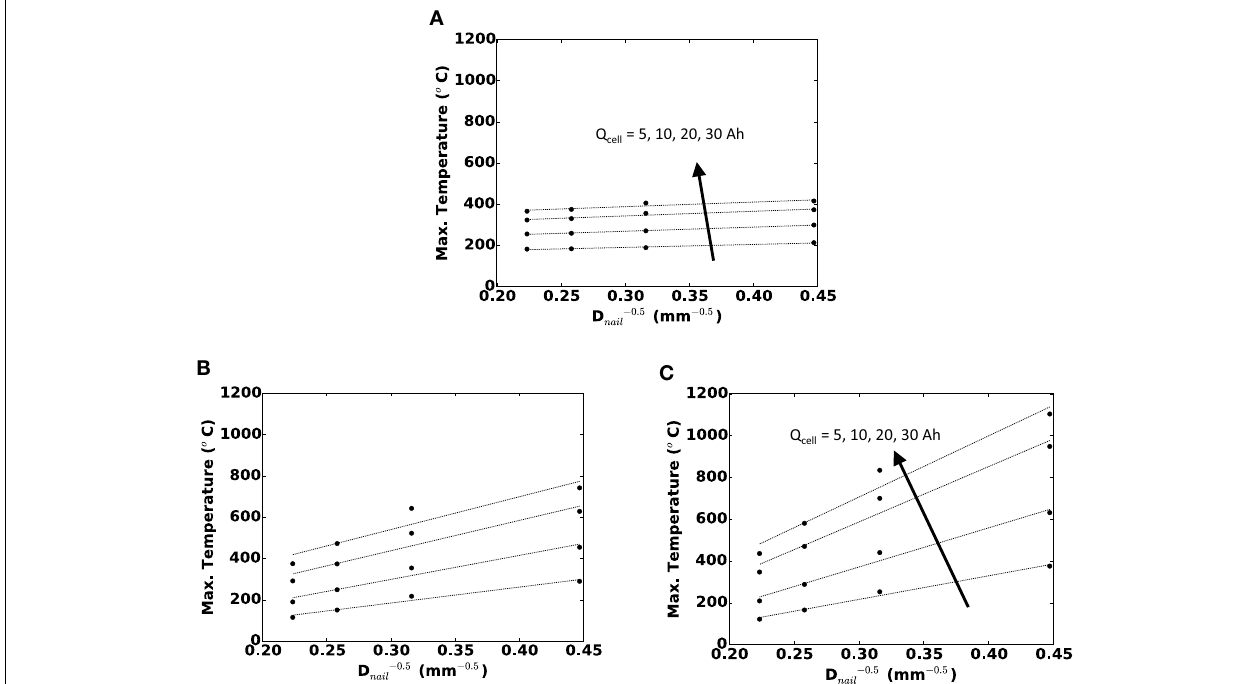
FIGURE 5 | Maximum local temperature versus ( D (cid:0) 0.5 nail ) for (A) small A foil , (B) medium A foil , and (C) large A foil .